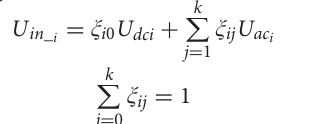
(3) CEC conversion stage. When the system operating point C moves so that the current deviation value is less than the set threshold, the current deviation control converted from the current control to extinction angle control, and finally stabilized at operating point